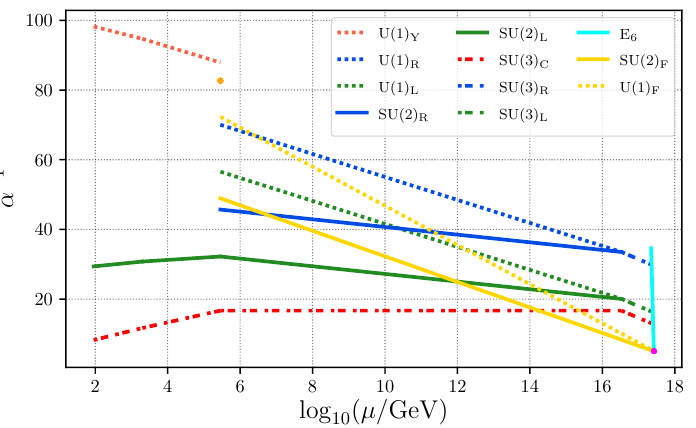
Figure 1. An illustration of RG evolution of the gauge couplings in the considered model for a parameter space point with a low-scale soft-SUSY breaking consistent with the SM. Here, all the soft-induced symmetry breaking scales (except M EW (cid:28) M S ) are assumed to be compressed for simplicity and are fixed to a universal value M S where the SM gauge symmetry emerges. The purple ( M GUT ) , while the orange dot shows the α − 1 ( M S ) value. The purple dot dot represents the universal α − 1 T U represents an example of a unified gauge couplings where non-perturbative effects can start playing